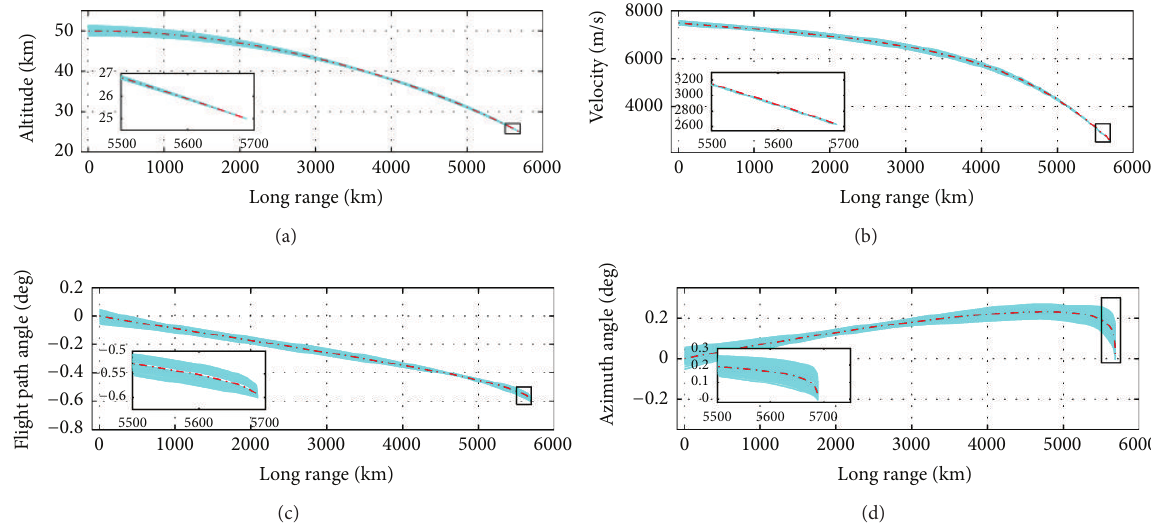
Figure 11: Simulation results. (a) Altitude, (b) velocity, (c) flight path angle, and (d) azimuth angle.